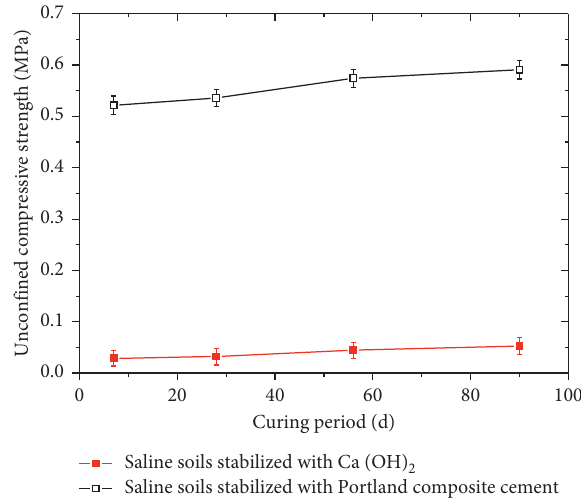
Figure 5: Variation in UCS during curing period of saline soils stabilised with Ca(OH)